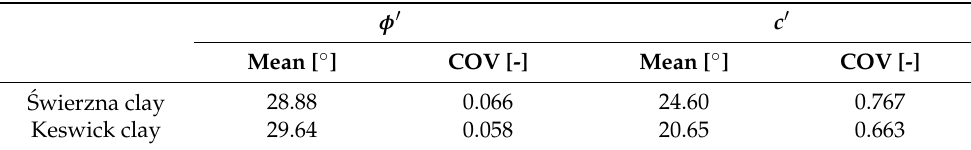
Table 6. Variability measures of parameters according to the NTH method.